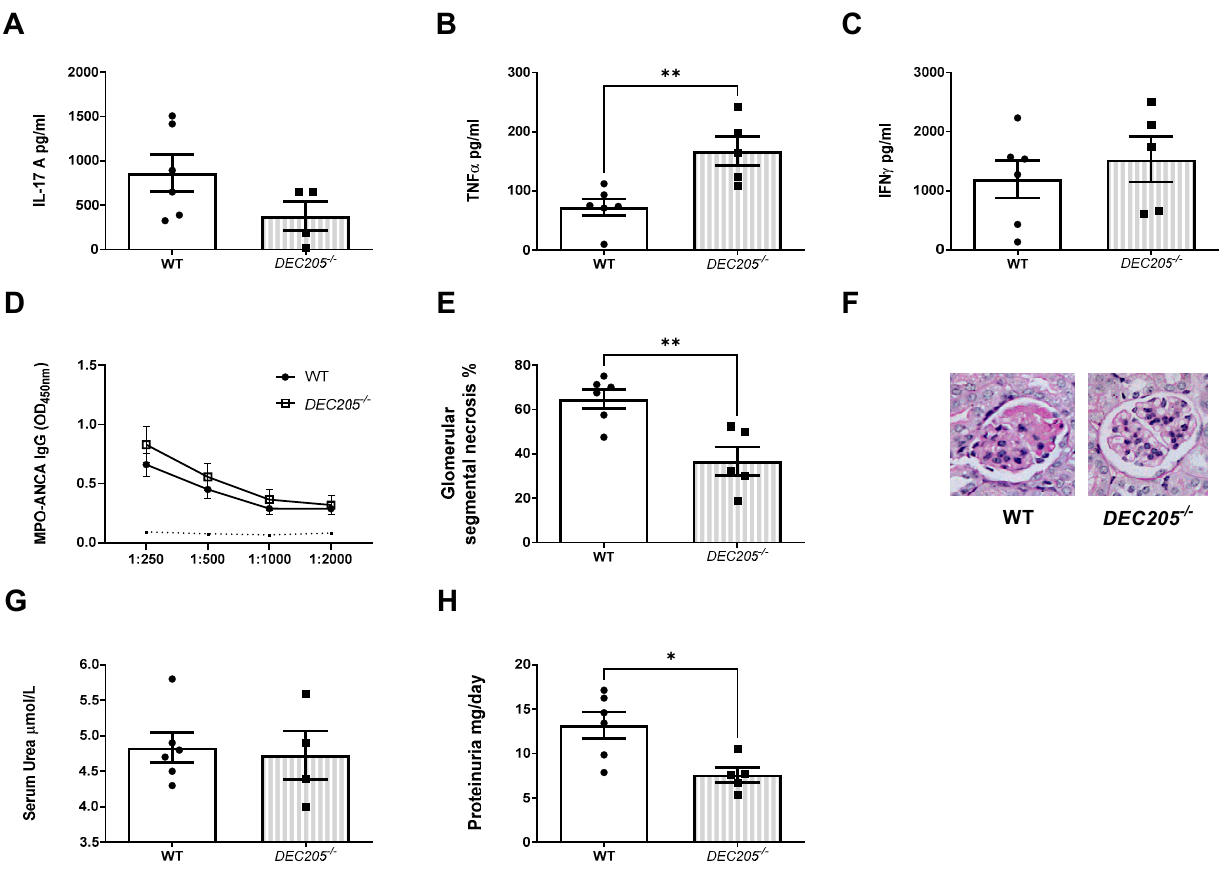
Figure 7. DEC205 is required for the development of Th17 MPO autoimmunity on transfer of TLR9 stimulated MPO pulsed dendritic cells. dendritic cell DEC205 deficiency protects from subsequent kidney injury. ( A ) Reduced production of IL-17A in mice receiving TLR9 stimulated MPO pulsed DEC205 − / − DCs compared to WT DCs. ( B ): Increased production of TNF- α in mice receiving TLR9 stimulated MPO pulsed DEC205 − / − DCs. ( C ): No difference in production of IFN- γ in mice receiving TLR9 stimulated MPO pulsed DEC205 − / − DCs. ( D ): No difference in serum MPO-ANCA IgG in mice receiving both TLR9 stimulated MPO pulsed DEC205 − / − and WT DCs compared to OVA injected mice. Dotted line represents the OD 450 of sera from control, OVA immunized mice receiving anti-GBM globulin. ( E , F ): Decreased kidney injury in mice receiving TLR9 stimulated MPO pulsed DEC205 − / − DCs. Periodic-acid Schiff-stained micrographs of glomeruli were taken at original magnification × 400. ( G ): Serum urea measurement in µ mol/L. No difference in mice DEC205 − / − TLR9 stimulated MPO pulsed DEC205 − / − DCs. ( H ): Proteinuria measured in mg/day. Reduced in mice receiving TLR9 stimulated MPO pulsed DEC205 − / − DCs. Bars show the mean +/ − SEM. * = p <0.05, ** = p < 0.01. DC = Dendritic cell. Mouse numbers for experiment: WT: n = 6, DEC205 − / − : n = 5. Kidney injury was attenuated in mice receiving DEC205 − / − dendritic cells (Figure 7E,F). Whilst serum urea measurements did not differ between mice receiving DEC205 − / − and WT cells (Figure 7F), 24 hourly protein excretion was reduced in those that received DEC205 − / − dendritic cells reflecting less severe functional kidney injury (Figure